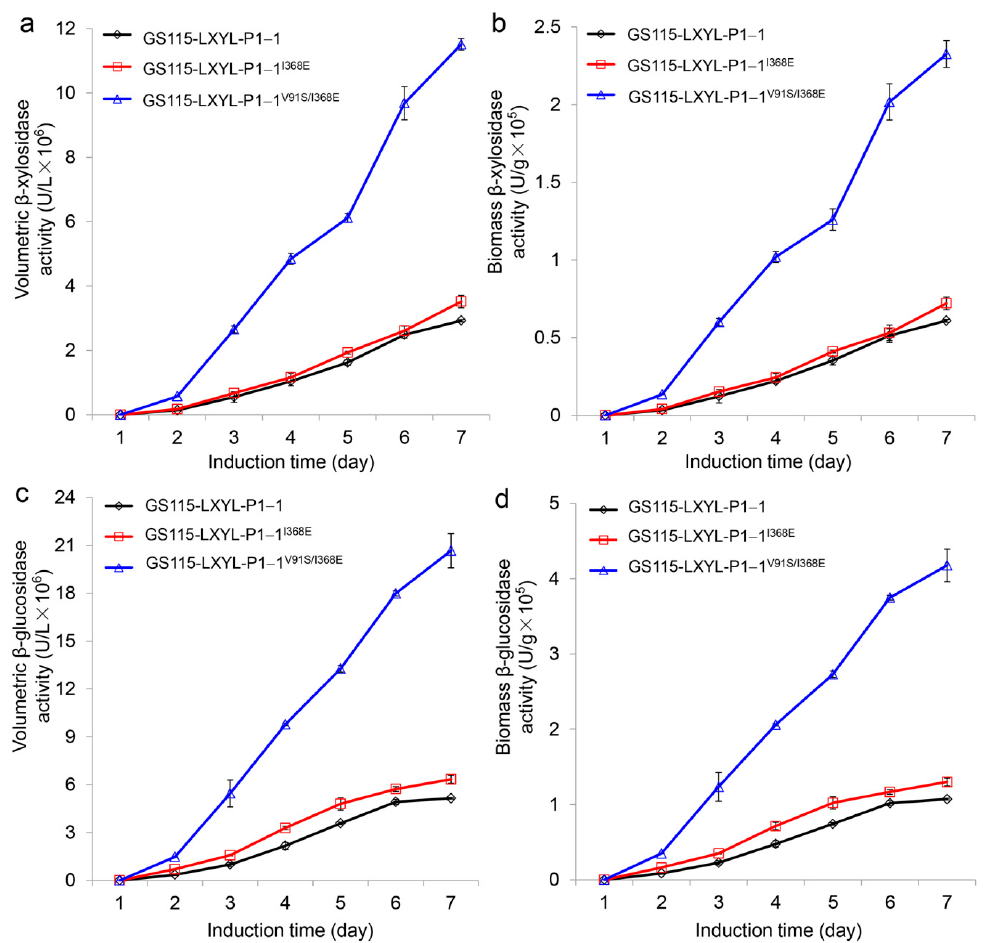
Figure 1. Comparison of β -xylosidase and β -glucosidase activities between the recombinant yeasts GS115-3.5K-LXYL-P1 − 1, GS115-3.5K-LXYL-P1 − 1 I368E , and GS115-3.5K-LXYL-P1 − 1 V91S/I368E . The recombinant yeast GS115-3.5K-LXYL-P1 − 1 was used as the control. ( a ) Volumetric β -xylosidase activities. ( b ) Biomass β -xylosidase activities. ( c ) Volumetric β -glucosidase activities. ( d ) Biomass β -glucosidase activities.